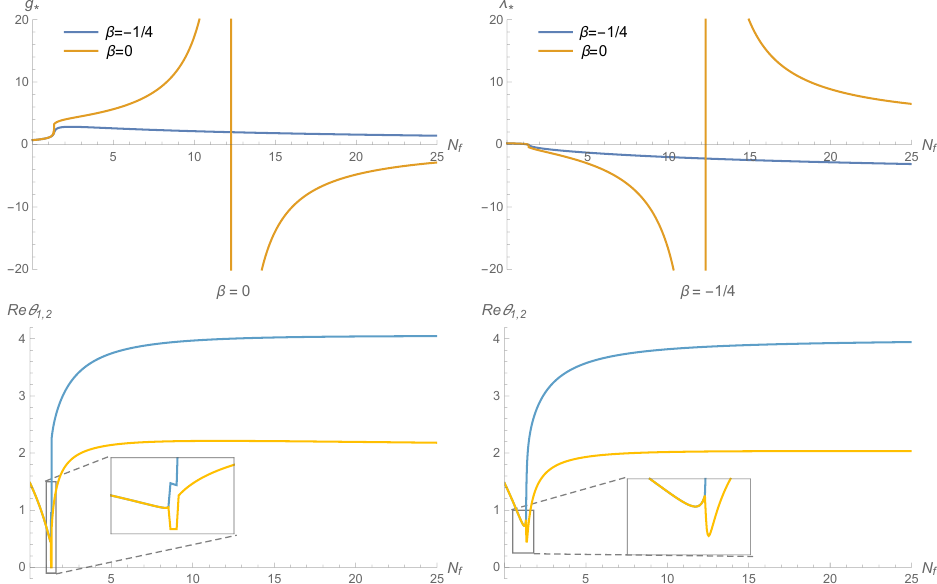
Figure 1. The position and critical exponents of the NGFP arising from (39) as function of N f . The blue and orange lines correspond to β = − 1/4 (coarse-graining by the Laplacian) and β = 0 coarse- graining by the squared Dirac operator). Notably, the NGFP exists for all values N f . For β = 0 there = 12.26 where the NGFP transition from g ∗ > 0 to g ∗ < 0. is a critical number of fermions N crit f